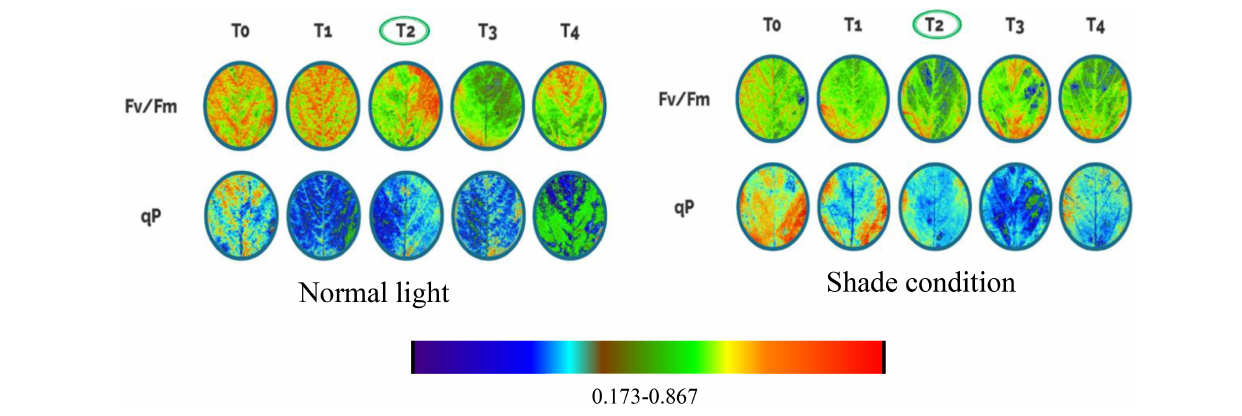
stem diameter and stem weight (Hussain et al., 2021), since the increment of stem diameter and snapping resistance was also observed in our study by the ratios of NH 4 + /NO 3 − (T2 and T3).